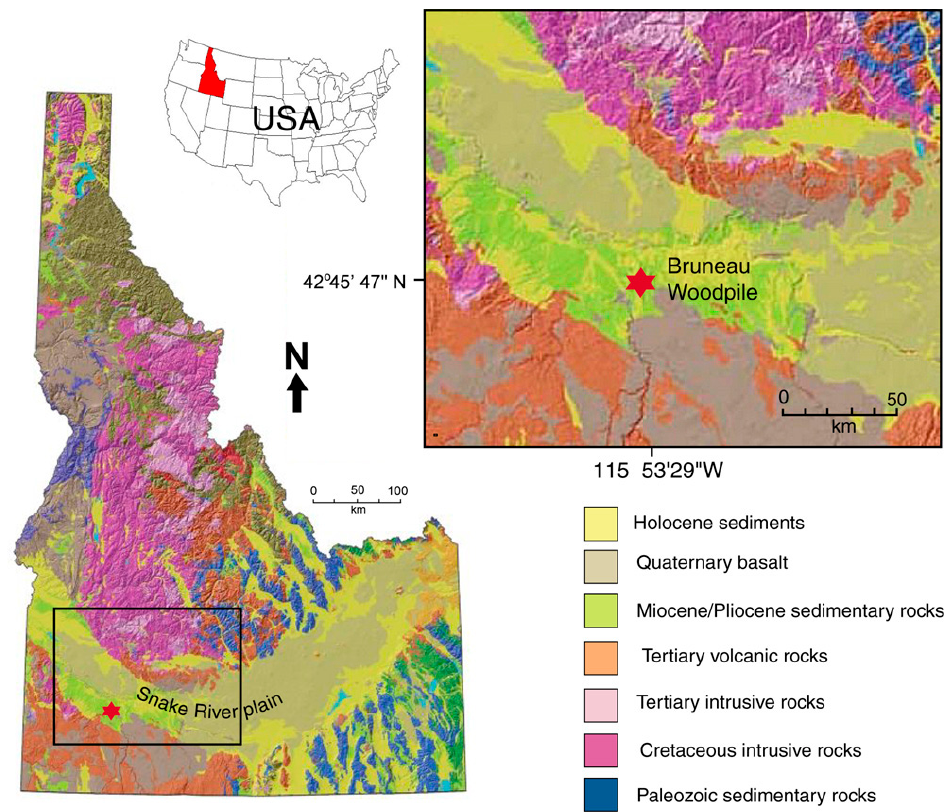
Figure 1. Location map adapted from Lewis et al. [1].